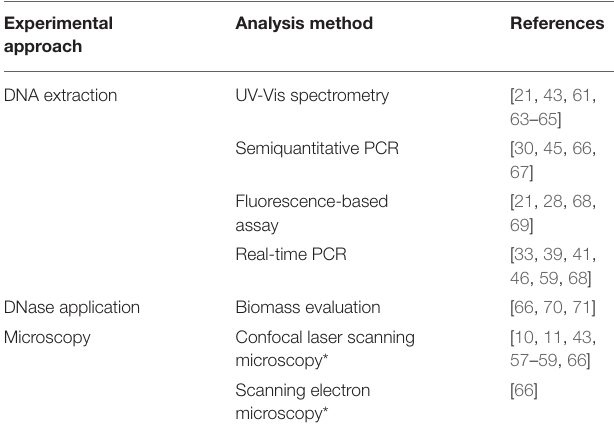
TABLE 1 | Methods for detection and quantification of eDNA within oral